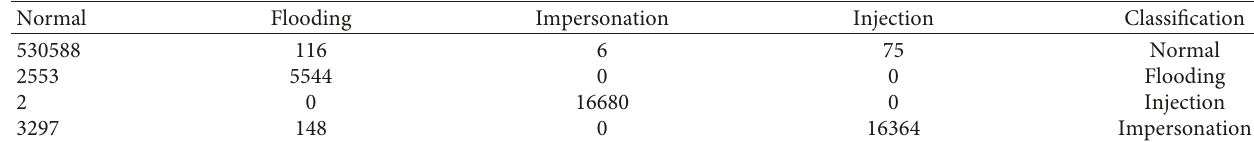
Table 5: Confusion matrix for AWID data set using J48 and IncrementalSSGC in proposed framework. Normal Flooding